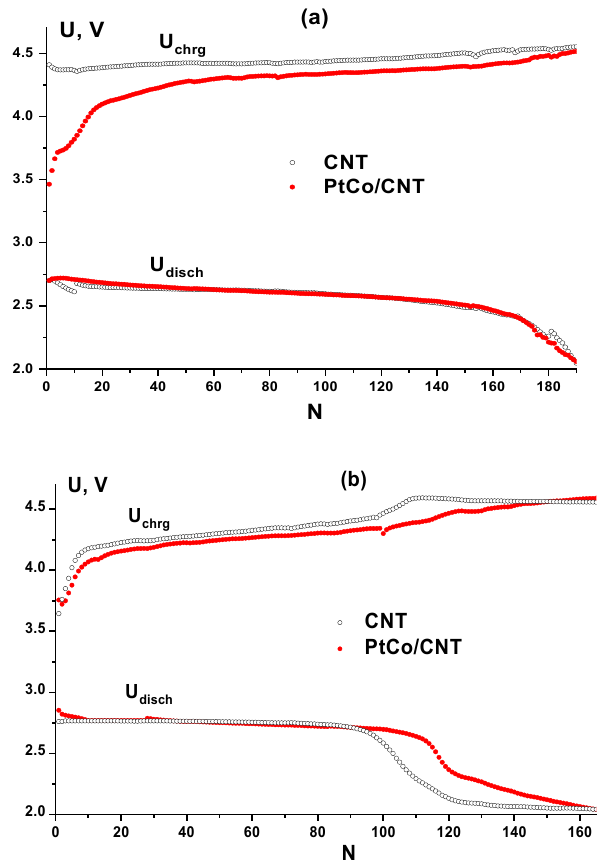
Figure 4. The dependences of discharge (U disch ) and charge (U chrg ) cutoff voltages of LOB on the cycle number. ( a ) 1M LiClO 4 /TEGDME; ( b ) 1M LiClO 4 /DMSO. O 2 atmosphere, discharge/charging capacity is 200 mAh/g, current density is 1C.